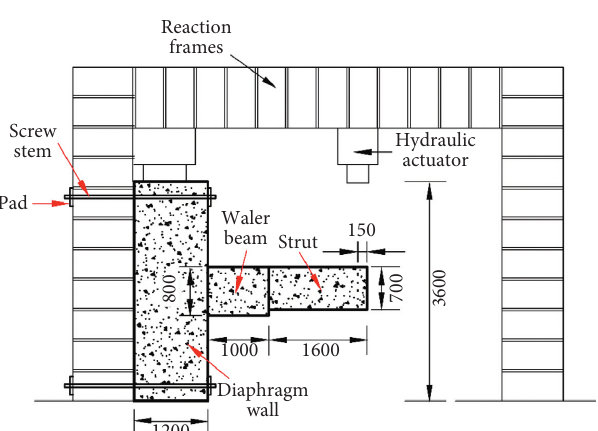
Figure 2: Test setup details (unit: mm).